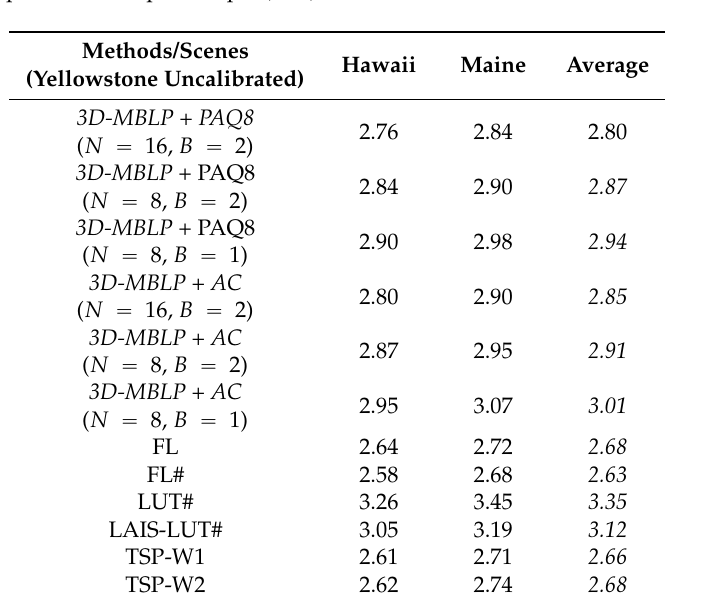
Table 16. Comparison with other lossless compression methods (12-bit uncalibrated images). The results are reported in bits-per-sample